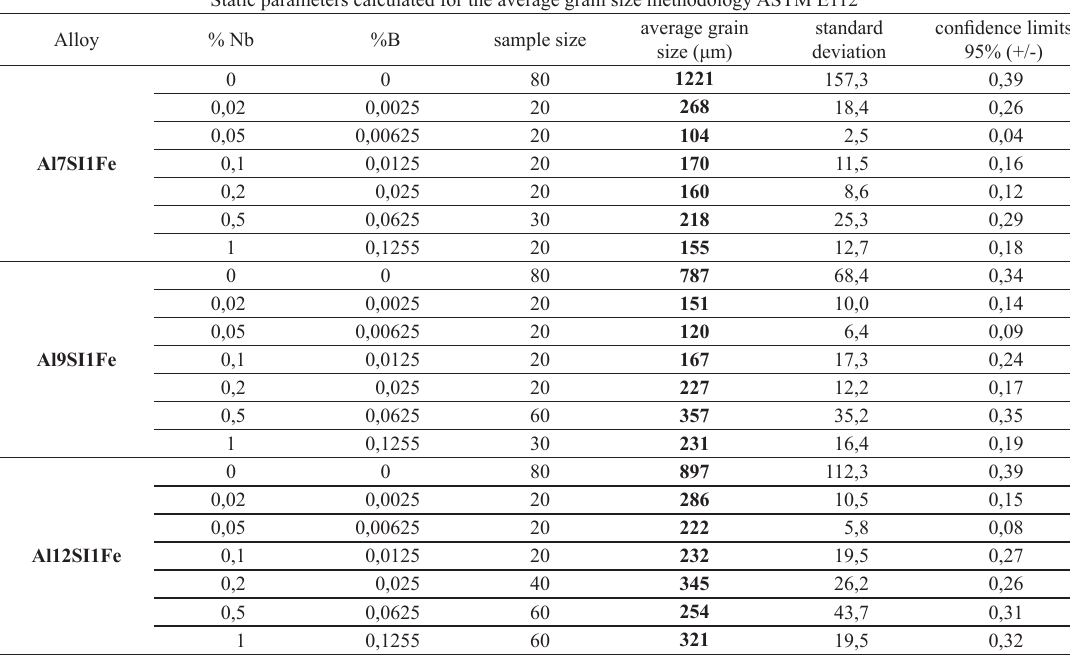
The average grain size was calculated using the manual methodology standardized according to the linear intercept method in the images. The values were registered Table 3. Static values calculated for the average grain size.